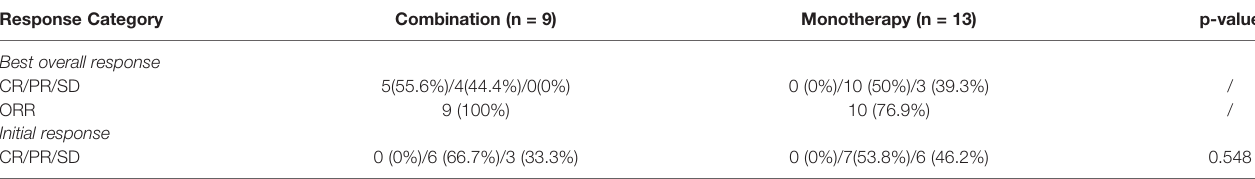
TABLE 2 | Responses to the treatment according to the mRECIST.